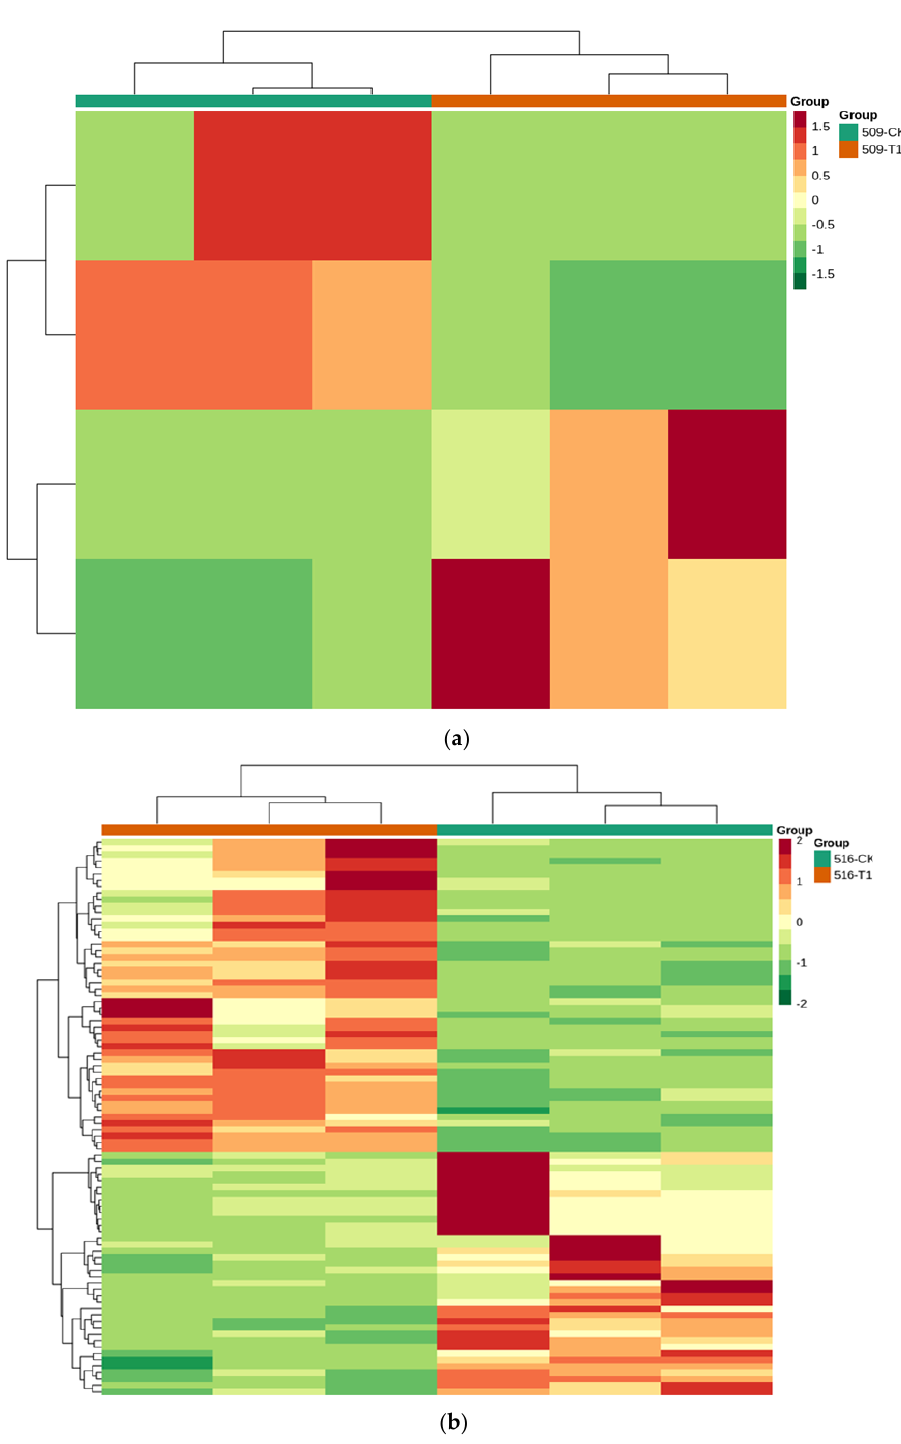
Figure 6. Hierarchical clustering heatmap of differentially expressed genes: ( a ) hierarchical clustering heatmap of differential genes between 509−CK and 509−T1; ( b ) hierarchical clustering heatmap of differential genes between 516−CK and 516−T1. Note: The abscissa represents the sample name and hierarchical clustering results, and the ordinate represents the differentially expressed gene and hierarchical clustering results shown in Figure 6. Red indicates high expression, and green indicates low expression; 509-CK and 509-T1 correspond to the control and high-Ca treatment groups, respectively, at 64 d after anthesis; 516 − CK and 516 − T1 correspond to the control and high-Ca treatment groups, respectively, at 71 d after anthesis.